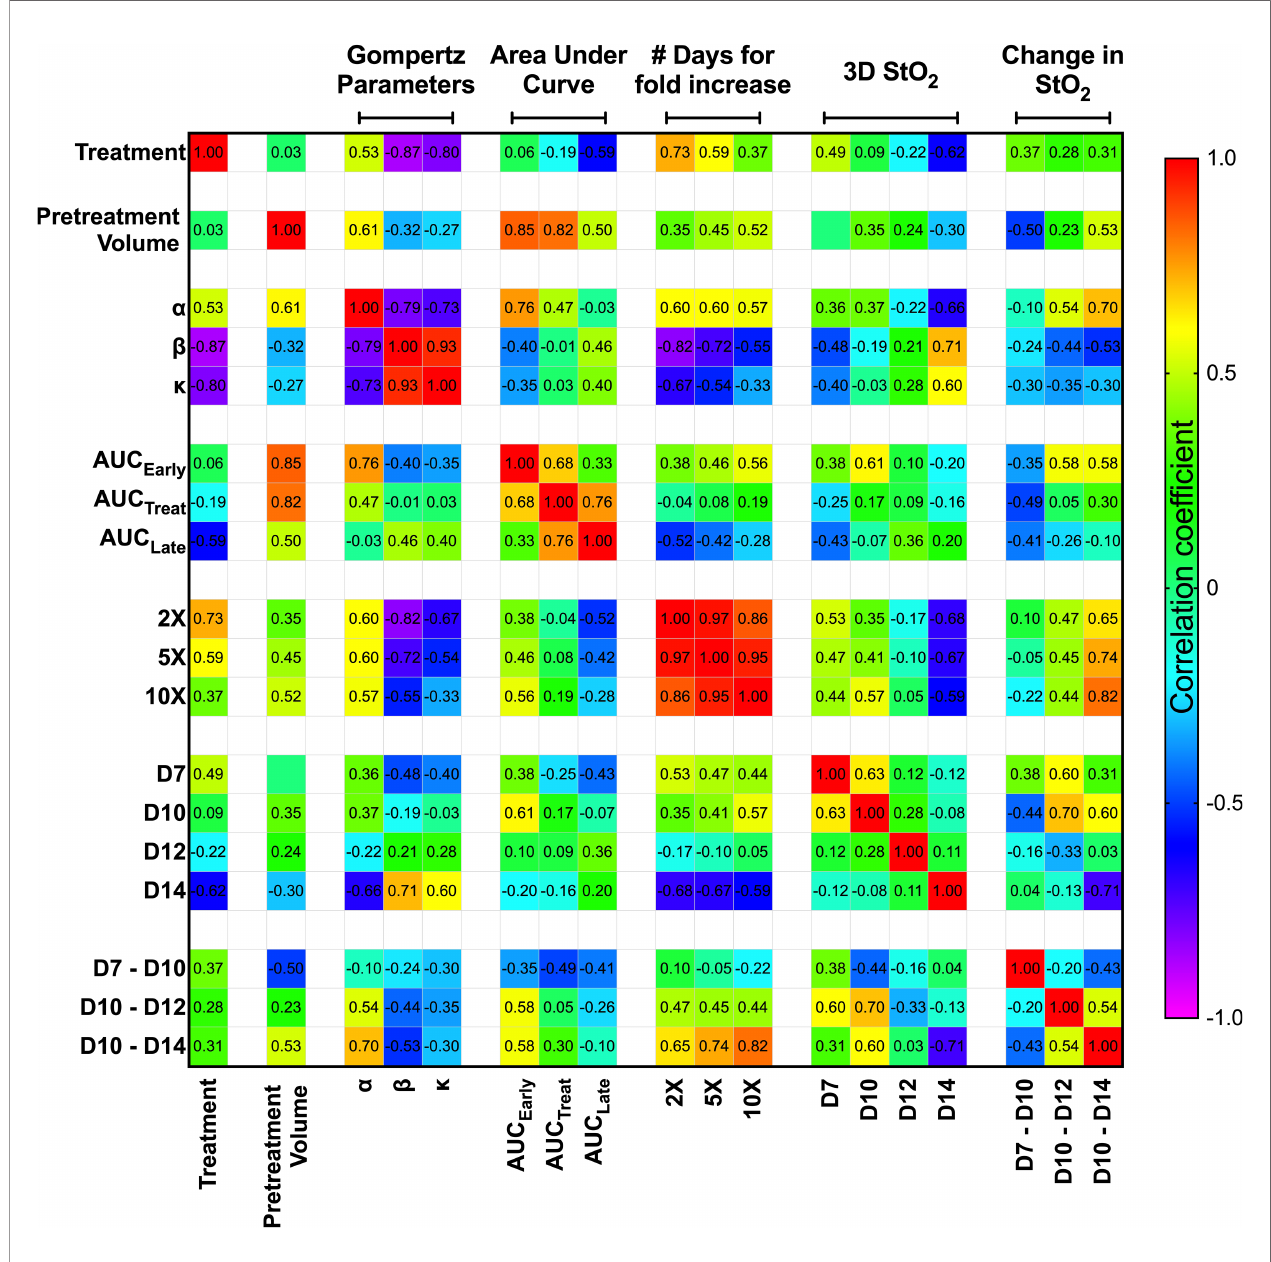
FIGURE 6 | Spearman correlation matrix comparing the tumor growth characteristics and tumor StO 2 parameters. Tumor growth parameters include pretreatment volume, Gompertz function parameters ( a , b , and k ), area under the growth curve obtained pretreatment (AUC Early ), during treatment (AUC Treat ), posttreatment (AUC Late ), and time taken for the tumors to reach twice (2×), 5 times (5×), and 10 times (10×) their pretreatment volume. The StO 2 parameters include the 3D StO 2 average values on Days 7, 10, 12, and 14 post-implantation (D7, D10, D12, and D14, respectively) and parameters describing the change in StO 2 from Day 7 to Day 10 (D7 – D10), Day 10 to Day 12 (D10 – D12), and Day 10 to Day 14 (D10 – D14). Color gradient assists in identifying the most prominent parameter relationships, with red representing a positive correlation coef fi cient and violet representing a negative correlation coef fi